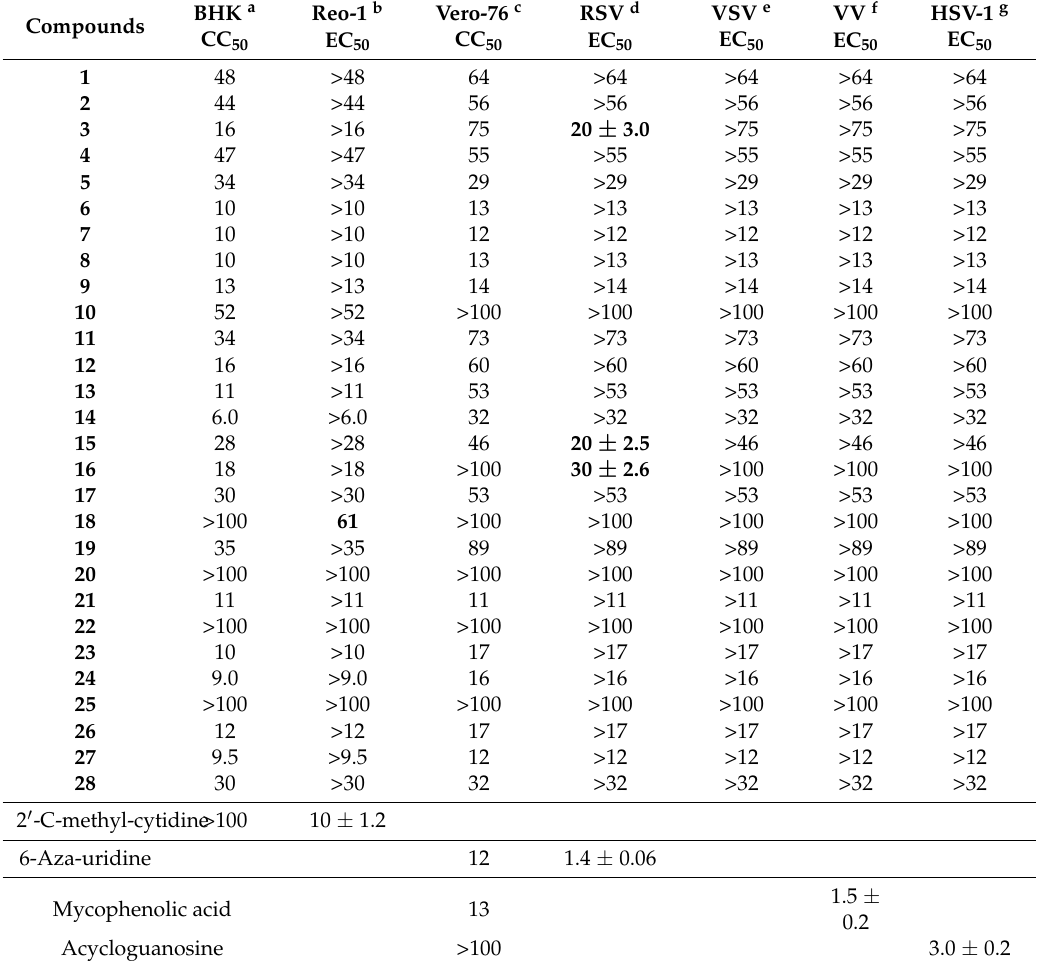
Table 6. Antiviral activity of thiourea derivatives against ssRNA-(RSV, VSV), dsRNA (Reo-1) and dsDNA (VV, HSV-1) viruses and cytotoxicity against the cell lines used in the